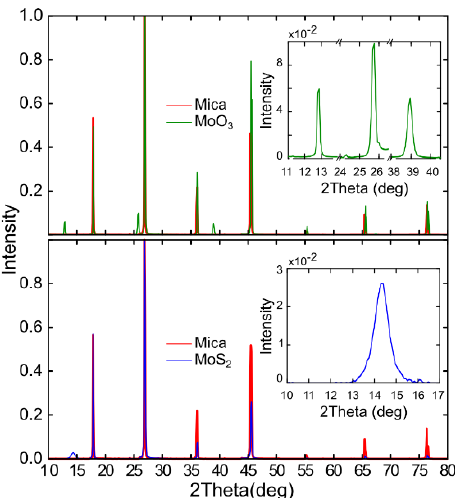
Figure 3. Comparison of XRD spectra of the sample shown in Figure 2, at di ff erent steps: MoO 3 (initial) and MoS 2 (after sulfuration) in green and blue, respectively. XRD spectra of a mica substrate in red to distinguish it from the peaks of the layer analyzed (insets).